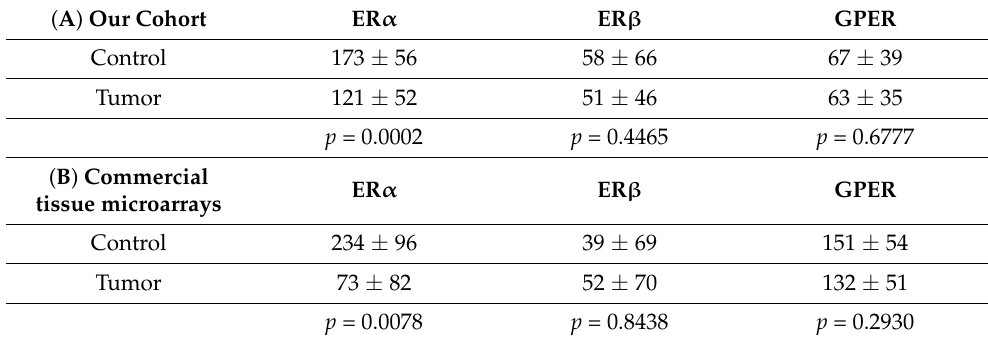
Figure 6. IHC scoring of ER α , ER β , and GPER staining of the 12 tissue samples from our cohort. Before-and-after graphs show ( A ) ER α (anti-ER α antibodies, 1D5, Dako, Cat. #: M7047, lot 1: 00034057, lot 2: 20015818), ( B ) ER β (anti-ER β antibodies, ab3576, Abcam, Cat. #: ab3576, Lot: GR208064-1), and ( C ) GPER (anti-GPER antibodies, HPA027052, Sigma-Aldrich, Cat. #: HPA027052, Lot: A61748) IHC from adjacent control endometrial tissue (Control) and EC tissue (Tumor). Table 2. IHC score and difference between EC and control endometrial